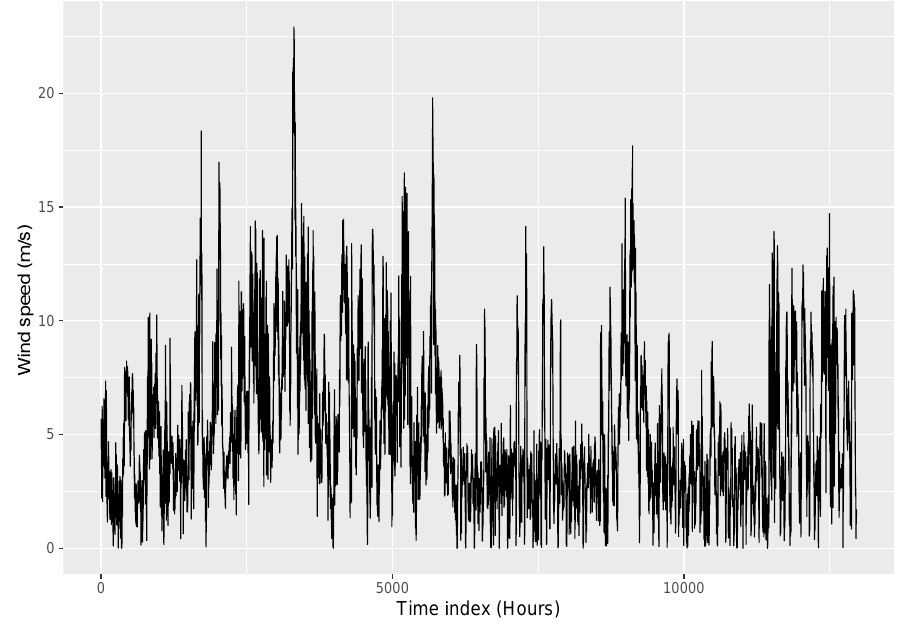
Figure 6. Mean wind speed time-series sampled at 10 min. Table 7. Statistical details of wind speed